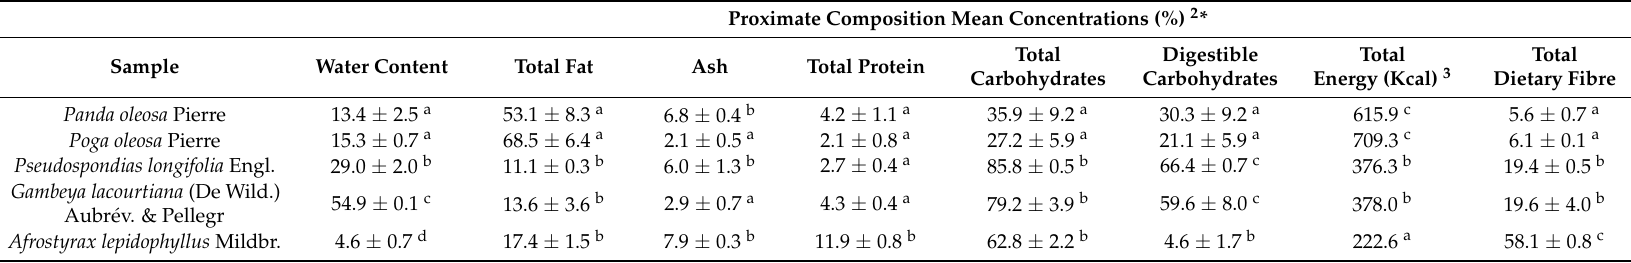
Table 1. Mean and standard deviations of proximate composition ‘wet basis’ 1 of the edible parts of five forest fruits and nuts consumed in Gabon.